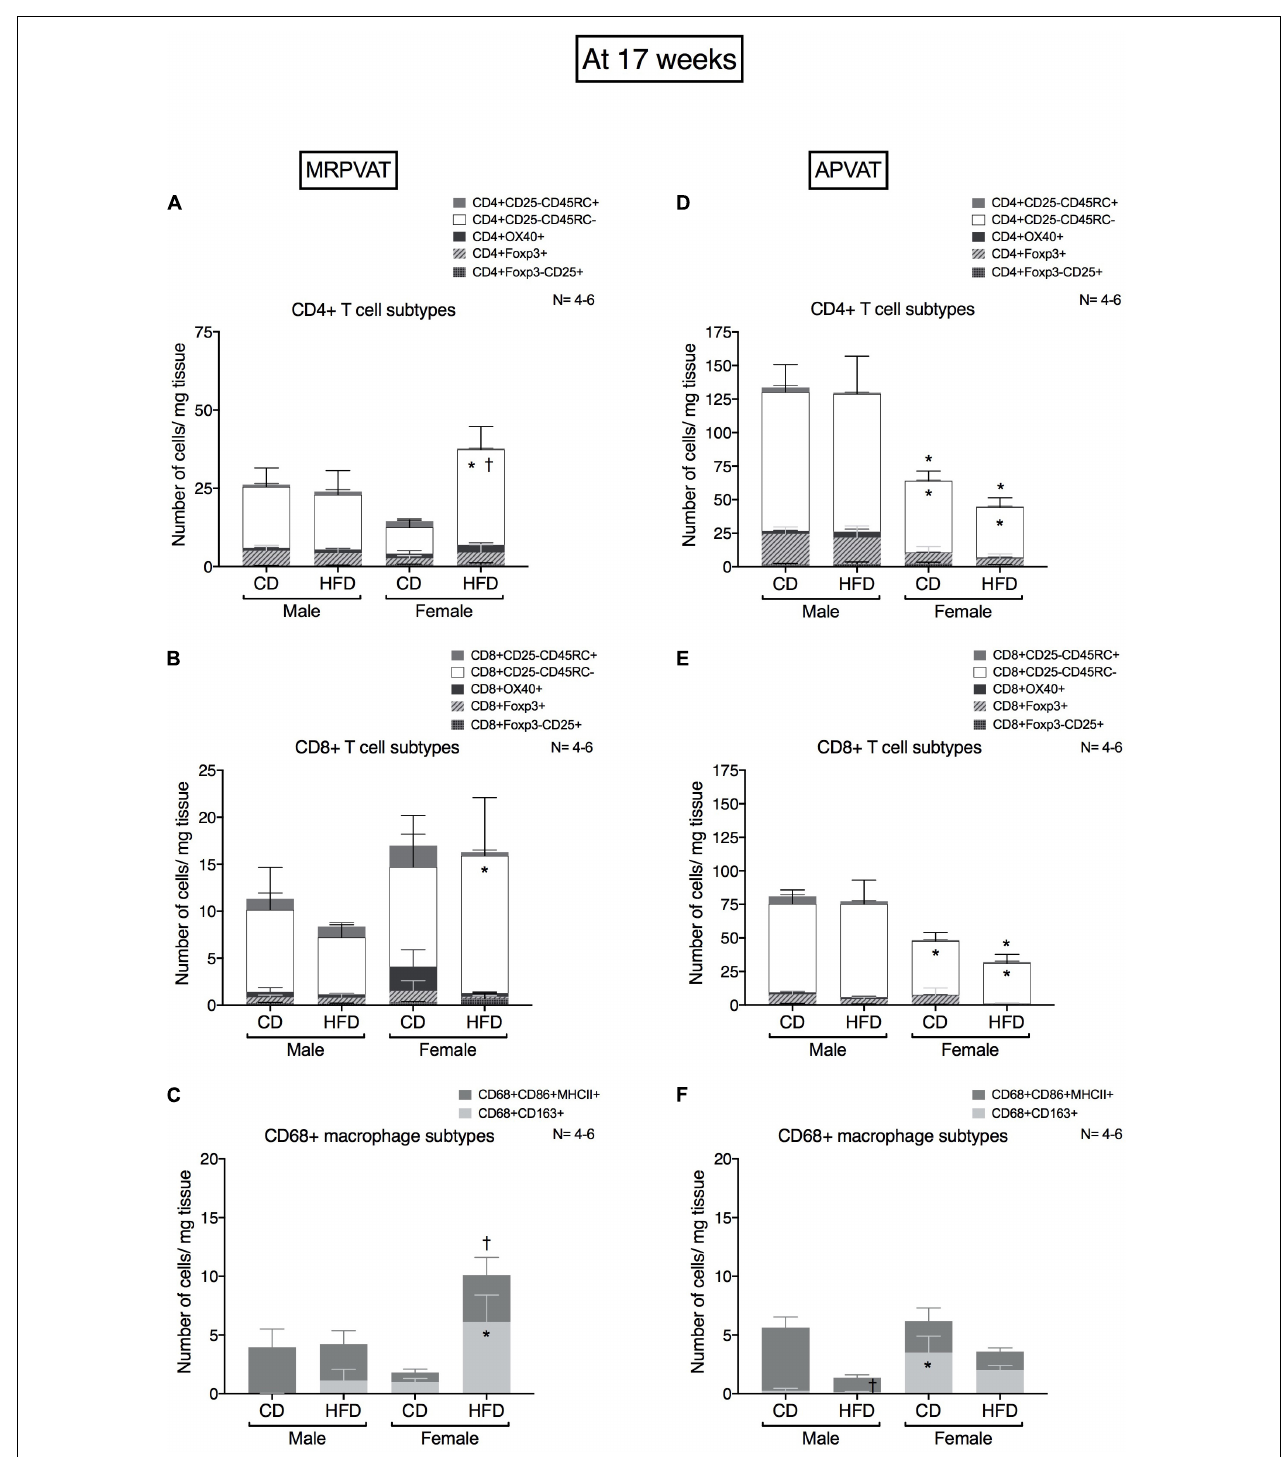
FIGURE 4 | Sex-differences in T cell and macrophage subtypes in PVATs peak at 17 weeks on diet, with the onset of hypertension. Subtypes of CD4 + , CD8 + T cells and CD68 + macrophages in MRPVAT and APVAT of both sexes at 17 weeks on diet (onset of hypertension with HFD) were quantified by flow cytometry. Subtypes of CD4 + T cells (A,D) , CD8 + T cells: cells (B,E) and CD68 + macrophages (C,F) were measured. Bars represent means ± SEM for the absolute cell counts of each immune cell type, normalized to tissue weight (in milligram). Number of animals is indicated by N. A P < 0.05 by 2-way ANOVA with Tukey’s test for multiple comparison, was considered statistically significant. * and † inside/outside the stacks in the graph represent a significant difference in the specific stack of immune cells/sum total of immune cells between the sexes within each diet and between the diets within each sex respectively.